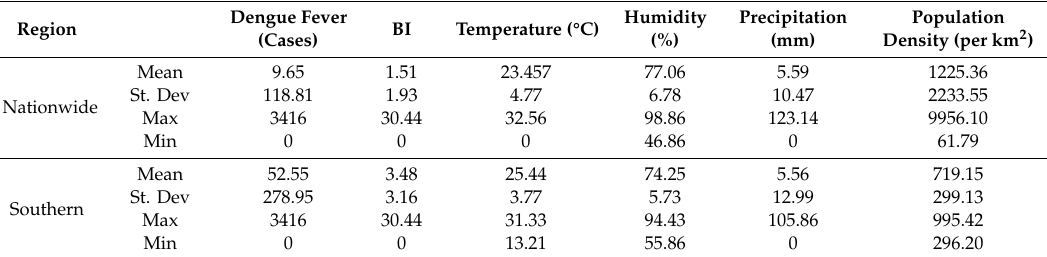
Table 1. Descriptive statistics of variables used in